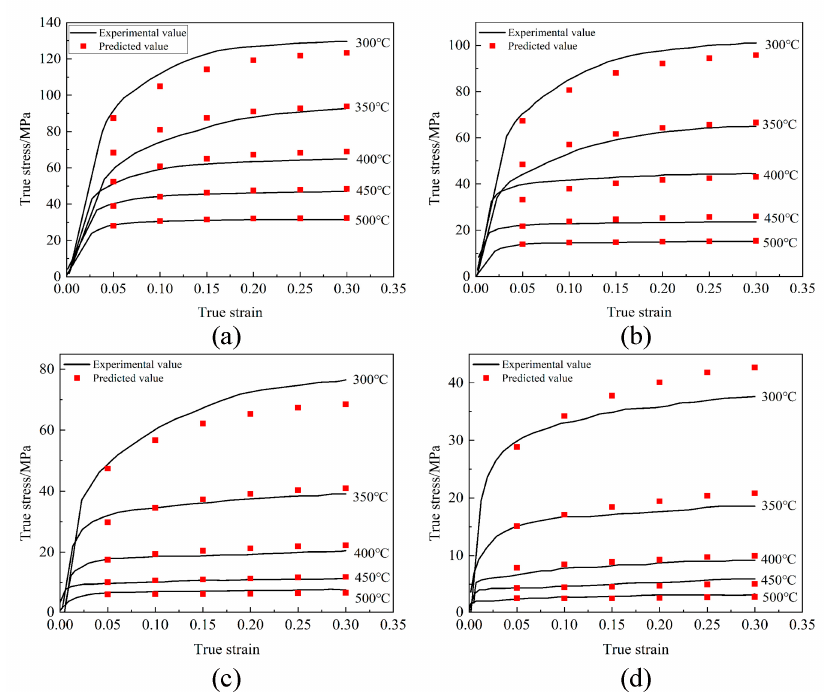
Figure 6. Comparison of experimental and predicted values for MnE21 magnesium alloy at different temperatures and strain rates: ( a ) ε (cid:4662) = 1 × 10 − 1 s − 1 ; ( b ) ε (cid:4662) = 1 × 10 − 2 s − 1 ; ( c ) ε (cid:4662) = 1 × 10 − 3 s − 1 ; ( d ) ε (cid:4662) = 1 × 10 − 4 s − 1 .